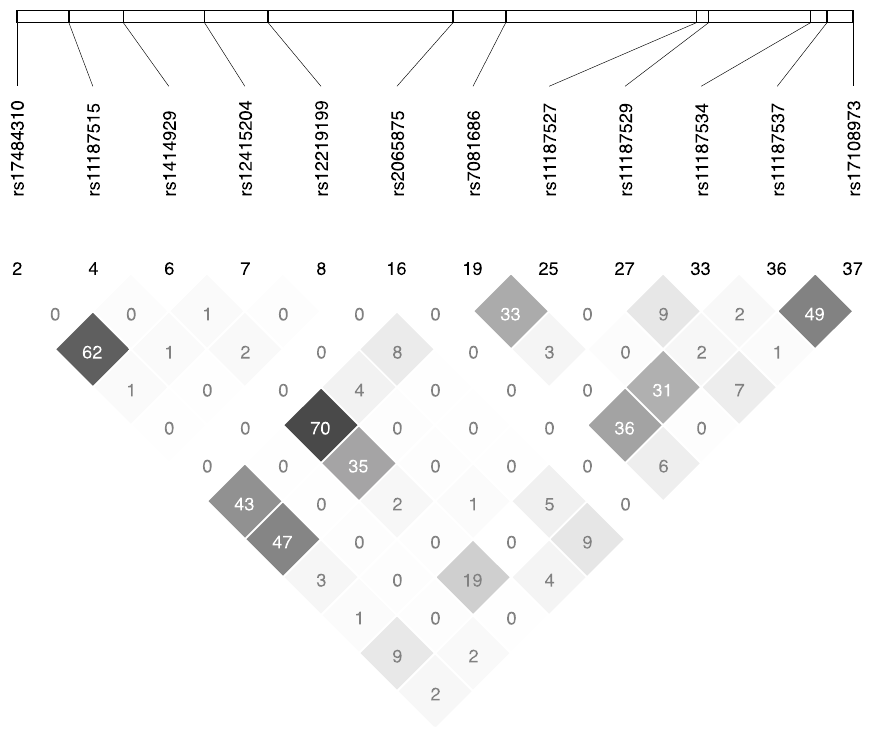
Figure 3. Linkage disequilibrium plot of selected SNPs in the FFAR4 gene.